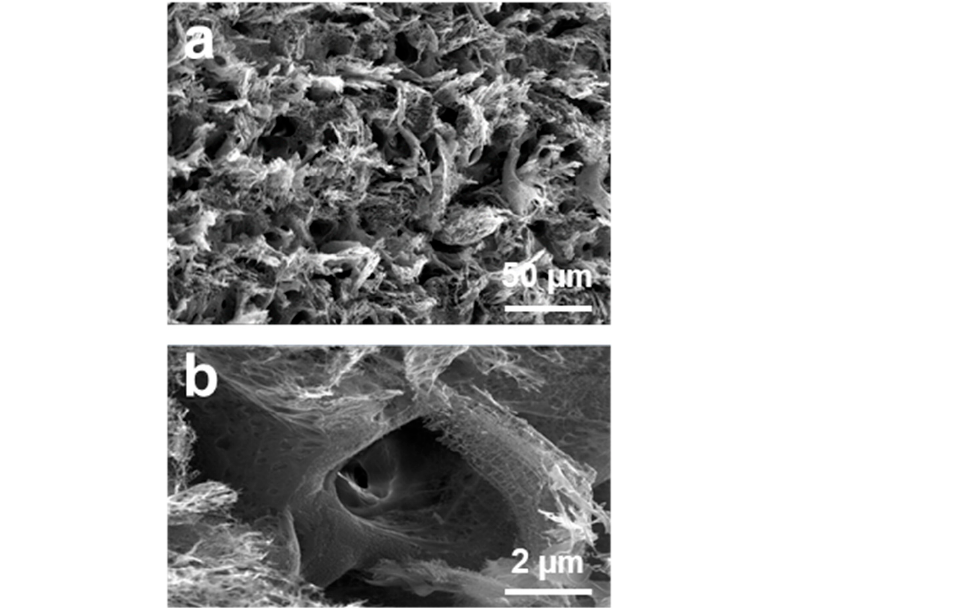
Figure 3 . ( a , b ) SEM images at different magnifications of the sintered PI tape surface, showing porous graphite microstructures.